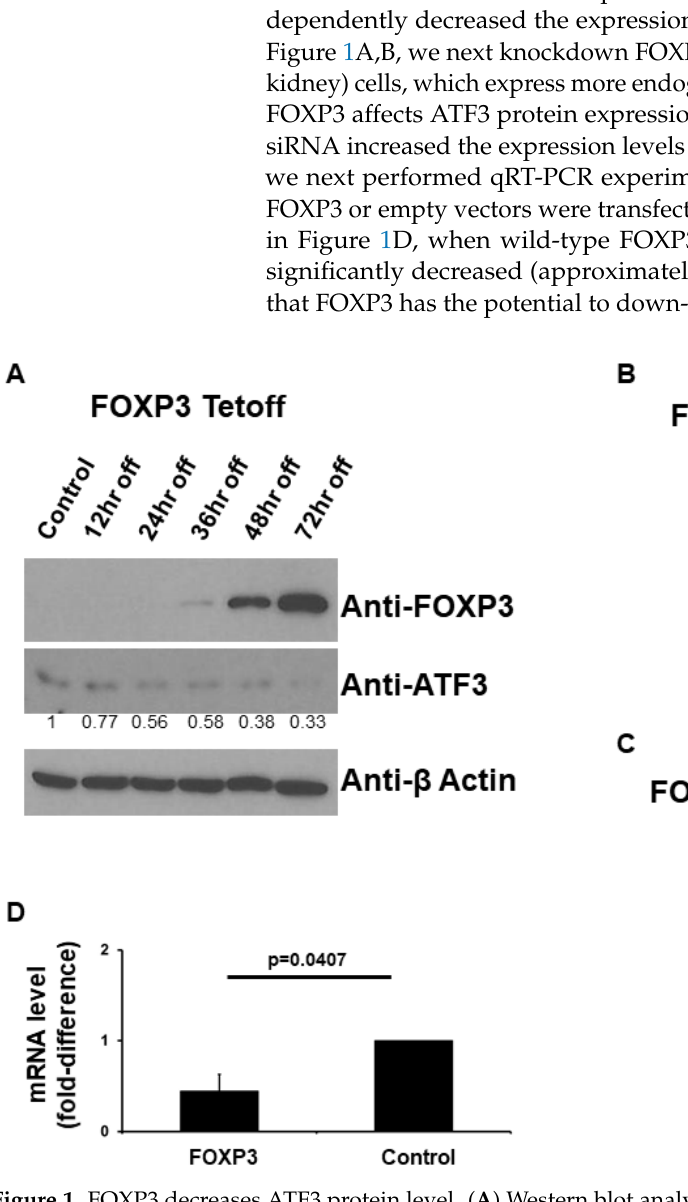
Figure 1. FOXP3 decreases ATF3 protein level. ( A ) Western blot analysis of ATF3 expression from FOXP3-Tet-off MCF7 cells. ( B ) Western blot analysis of ATF3 expression from FOXP3 over-expressed MCF7 cells. ( C ) Western blot analysis of ATF3 expression from HEK293 cells treated with FOXP3 siRNA. The expression levels of FOXP3 and ATF3 were determined using anti-FOXP3 and anti-ATF3 immunoblotting, respectively. The β -Actin levels were also determined for equal loading. ( D ) Real-time RT-PCR analysis of ATF3 expression by FOXP3 from MCF7 human breast cancer cells. Total RNA was extracted from cells and then reverse transcribed to cDNA followed by qPCR analysis with glyceraldehyde-3-phosphate dehydrogenase (GAPDH) as an internal control. The experiments were performed two times, each with triplicate samples. Error bars indicate standard errors.